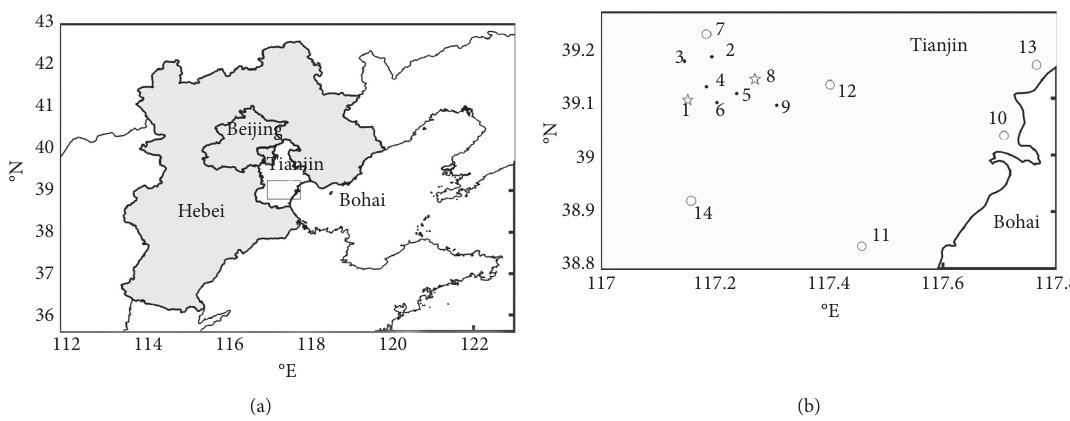
Figure 1: (a) Map of the Beijing-Tianjin-Hebei region. The rectangle in Tianjin is the study area of (b). (b) Location of 14 monitoring stations in Tianjin. From 1 to 14, they are located in the city testing center, Nankou Road, Qinjian Road, Nanjing Road, Dazhigu No. 8 Road, Hanbei Road, and Tuanbowa. The stars represent the missing data stations (stations 1 and 8), the black dots represent the stations used for the interpolation (stations 2, 3, 4, 5, 6, and 9), and the circles represent the stations far from the missing data stations (stations 7, 10, 11, 12, 13, and